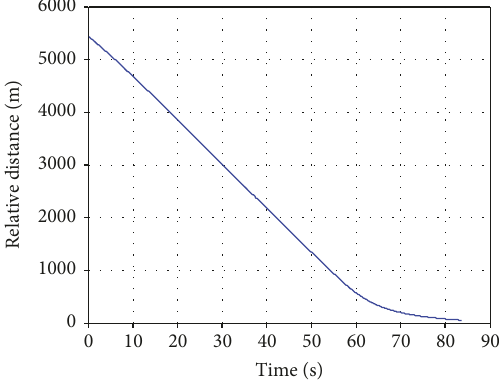
Figure 5: Relative distance.